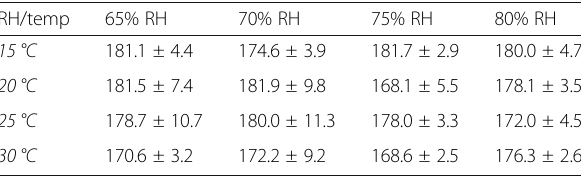
Table 1 Mean hyphal segment length of R. solani averaged over four replicates and over time RH/temp